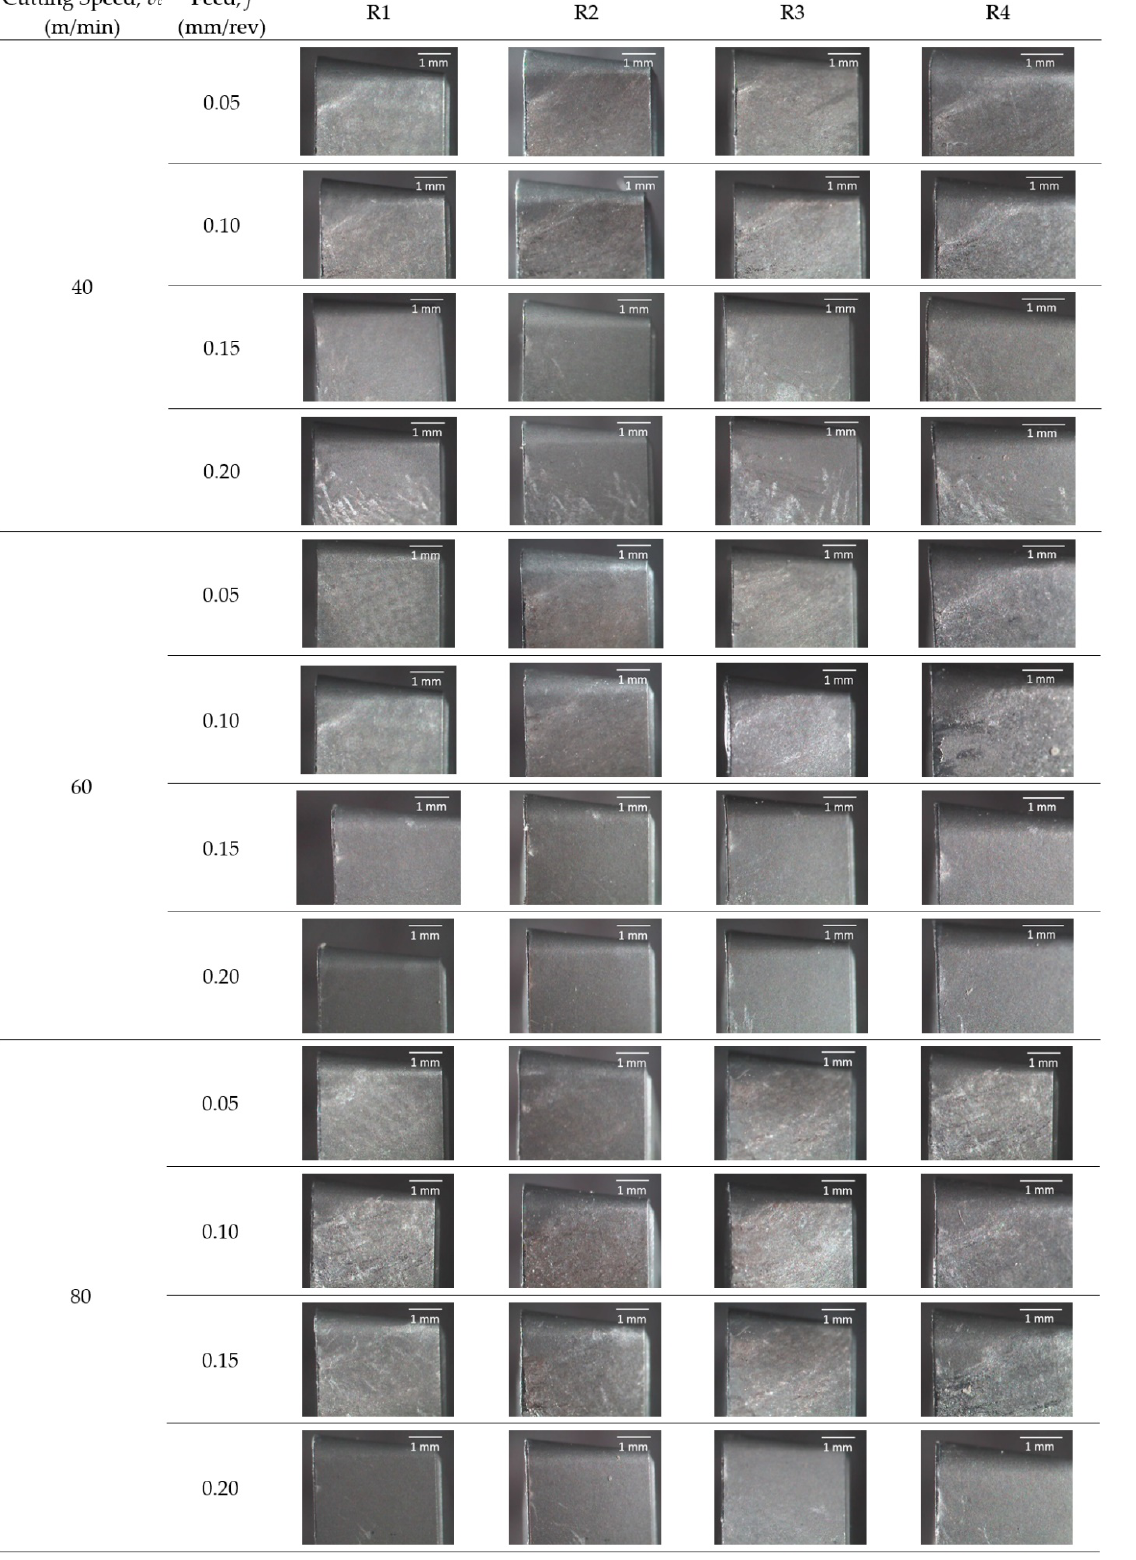
Figure 7. SOM images (30–40×) of the tool flank face after machining test for each cutting parameters combination.